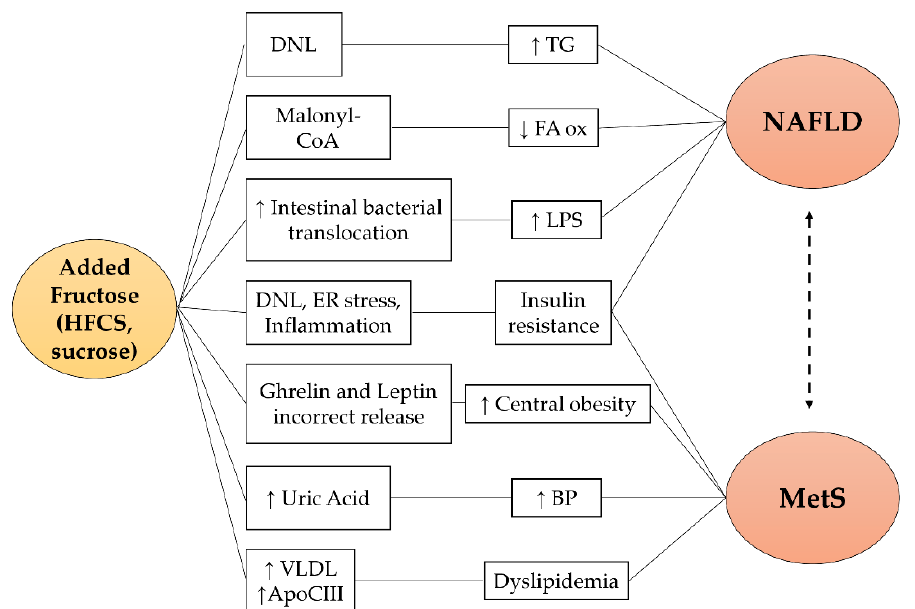
Figure 2. Fructose-related pathogenetic pathways in NAFLD and MetS. Fructose promotes NAFLD and MetS via different pathways: (1) it acts as a substrate and inducer of hepatic DNL resulting in steatosis and insulin resistance; (2) it is a precursor of malonyl CoA, an inhibitor of fatty acids oxidation; (3) it increases uric acid synthesis which is associated with hypertension; (4) it induces Apo CIII expression and the secretion of VLDL promoting dyslipidemia; (5) it favors intestinal bacterial translocation resulting in elevated serum LPS levels, closely associated with NAFLD; (6) it causes an incorrect regulation of the hunger–satiety mechanism which favors greater caloric intake and weight gain. HFCS: high fructose corn syrup; DNL: de novo lipogenesis; ER stress: endoplasmic reticulum stress; VLDL: very low-density lipoprotein; Apo CIII: apolipoprotein C-III; TG: triglycerides; FA ox: fatty acids oxidation; LPS: lipopolysaccharide; BP: blood pressure; NAFLD: non-alcoholic fatty liver disease; MetS: metabolic syndrome.